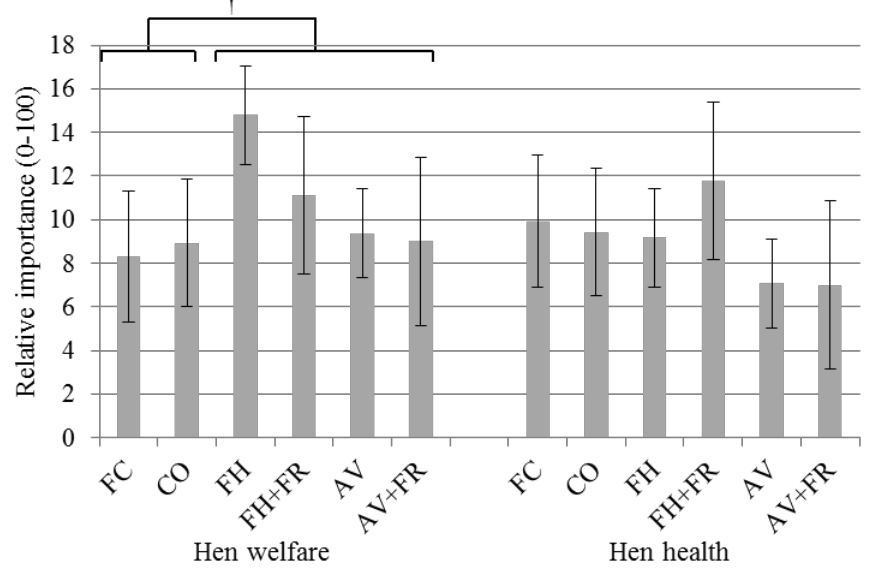
Figure 1. Importance of hen welfare and health as criteria for choosing a new